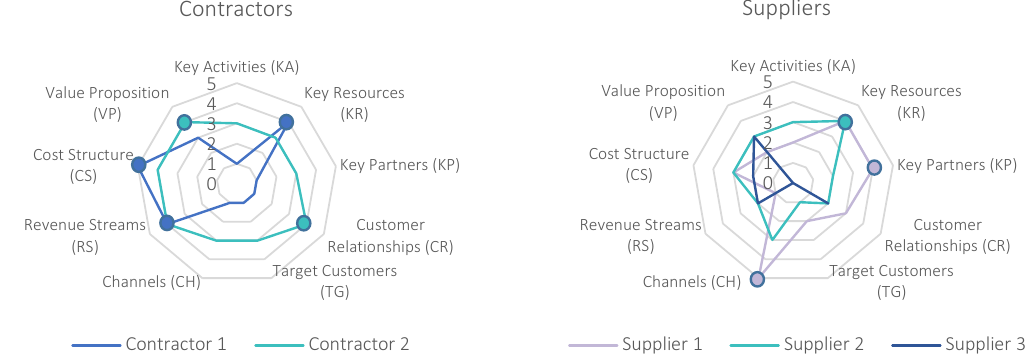
Figure 2. Business model structural changes through the introduction of new ROV